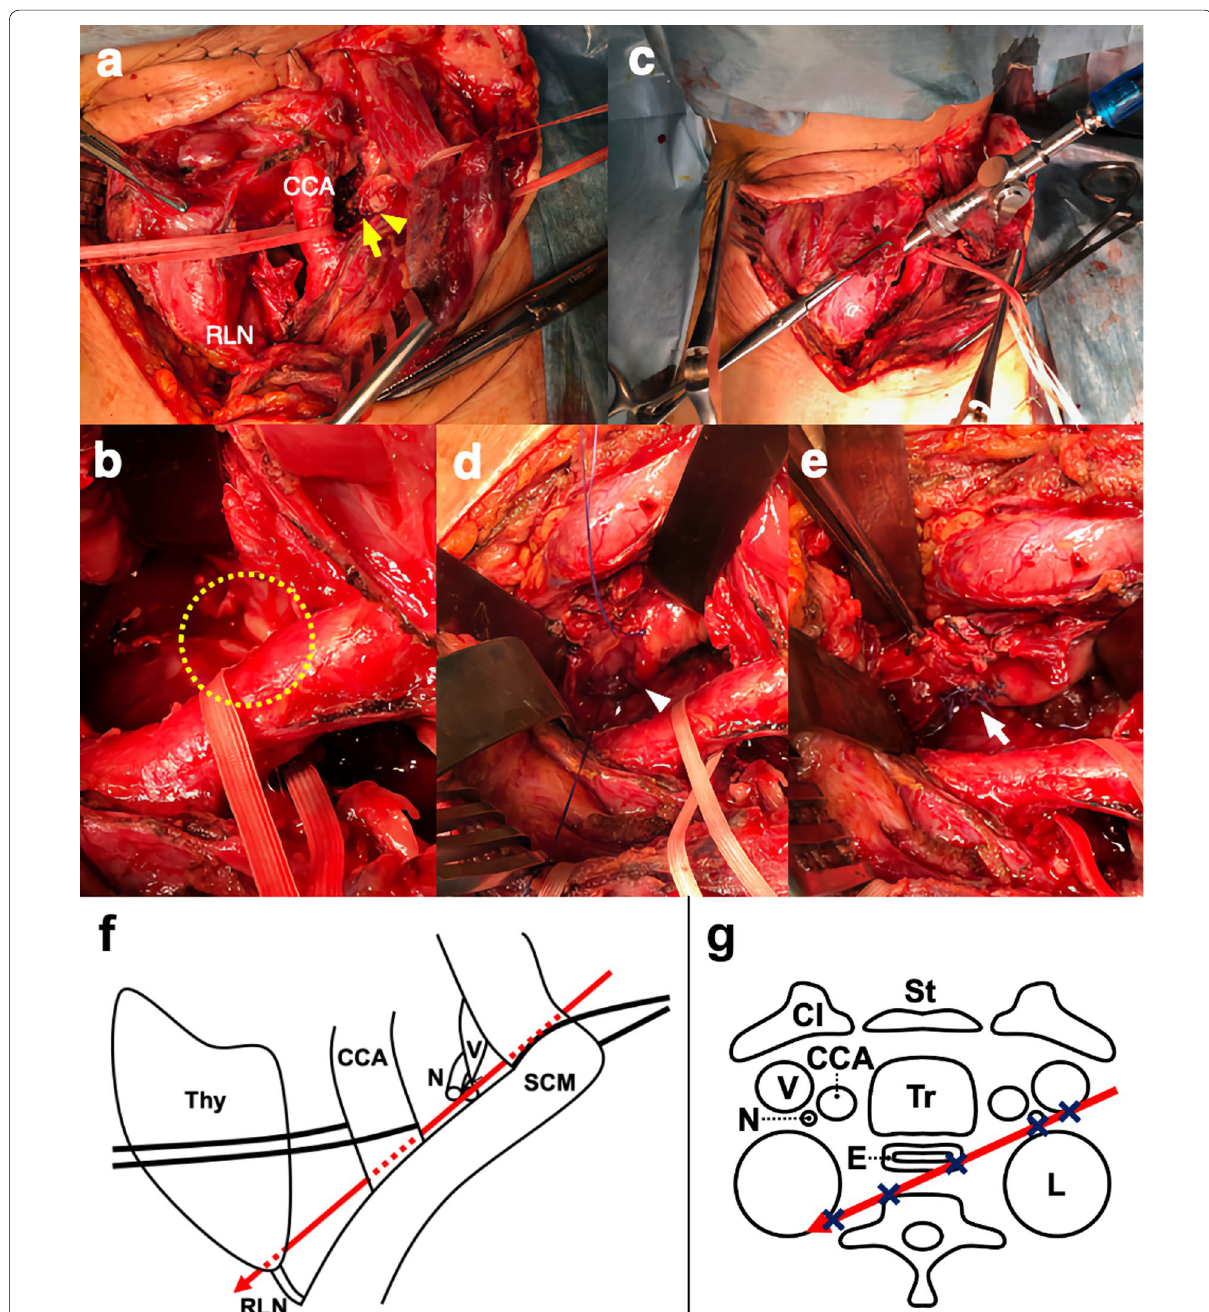
Fig. 3 Intraoperative findings. a The common carotid artery and the damaged vagus nerve (yellow arrow) were found on the ligated internal jugular vein’s dorsal side (yellow arrowhead). CCA: common carotid artery. RLN: recurrent laryngeal nerve. b A scar was found on the anterior surface of the vertebral body (yellow dotted line). c The scar reached the right thoracic cavity. d A 2-cm injury site on the left esophageal wall near the sternum’s superior border was present (white arrowhead). e The injury site was sutured using absorbable thread (white arrow). f The scheme of intraoperative viewing. g The scheme of the horizontal cross section. Red arrow is wound pathway and x is the damaged part. Thy thyroid gland. CCA common carotid artery. N vagus nerve. V internal jugular vein. RLN recurrent laryngeal nerve. SCM sternocleidomastoid. Cl clavicle. St sternum. Tr trachea. E esophagus. L